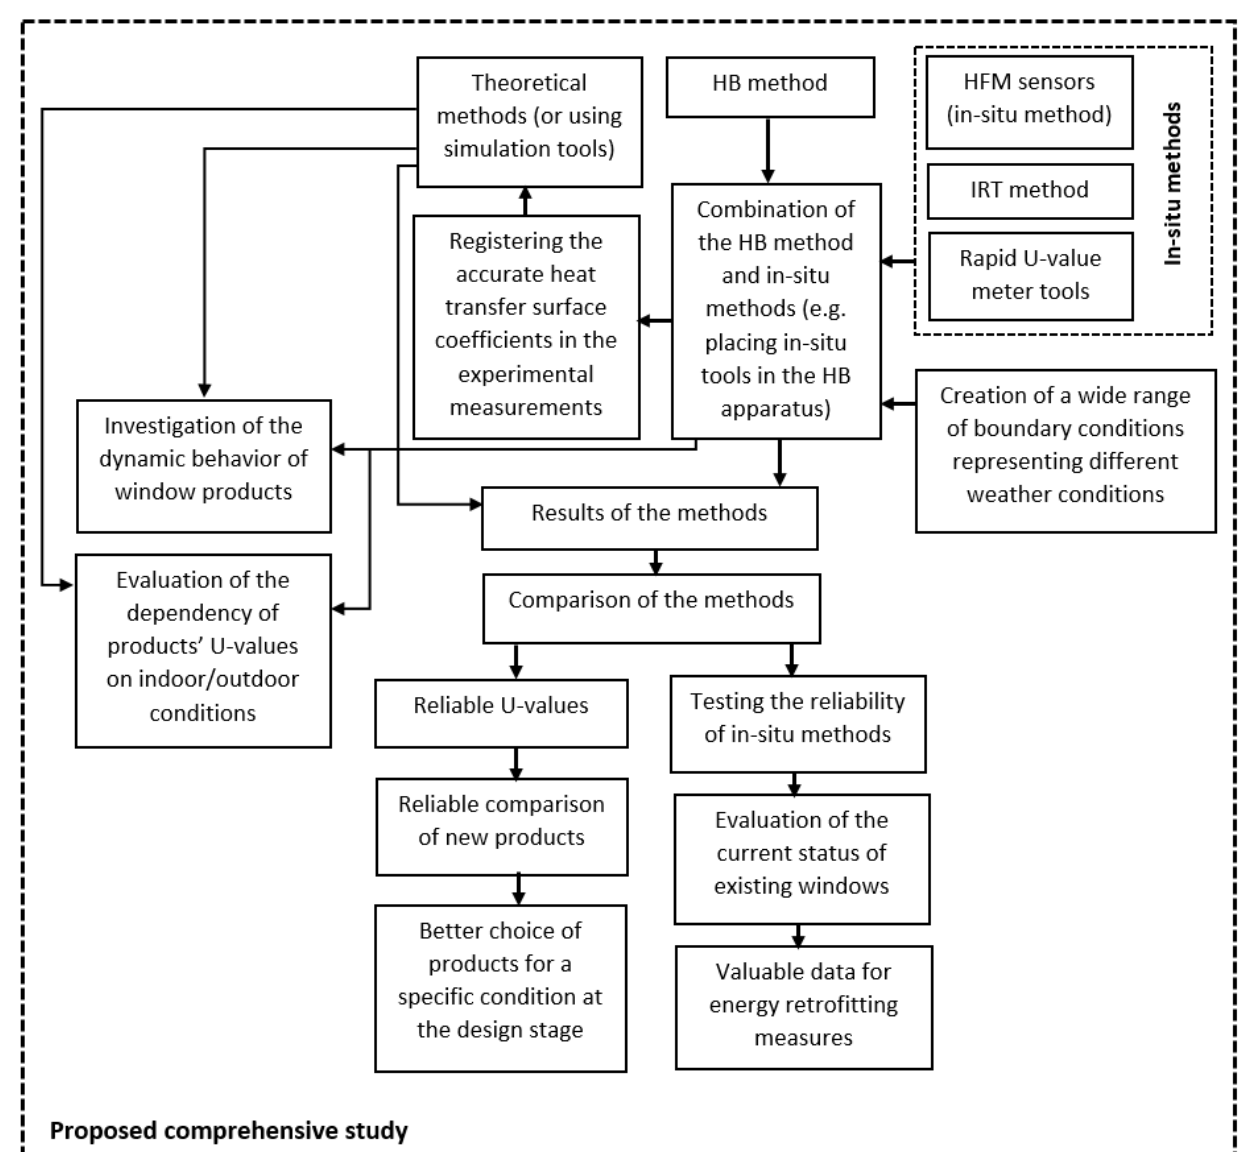
Figure 16. The comprehensive study proposed by the authors.